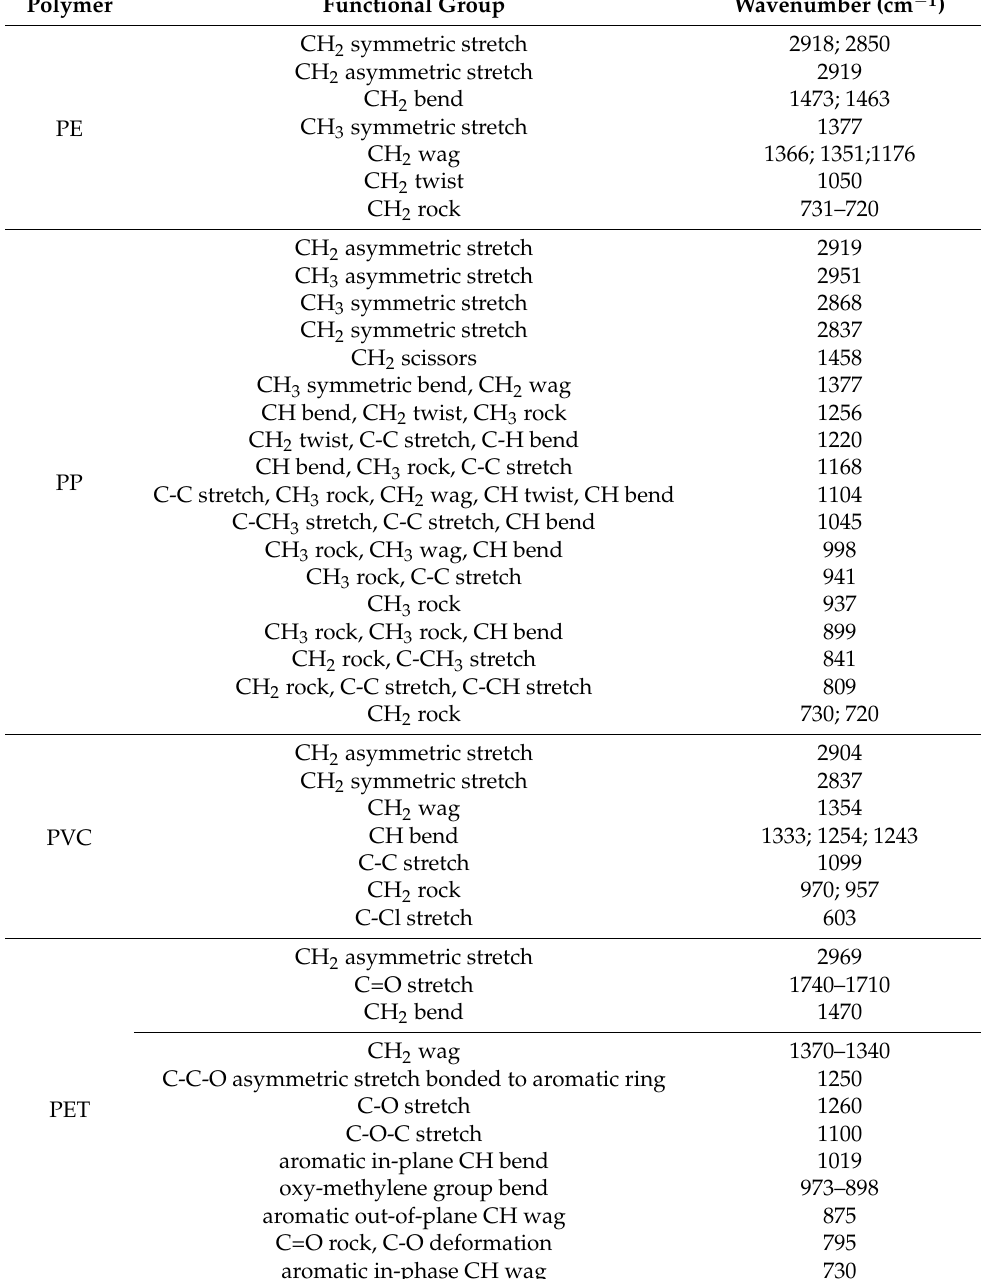
Functional groups of the most used polymers and their wavenumbers in FTIR spectra